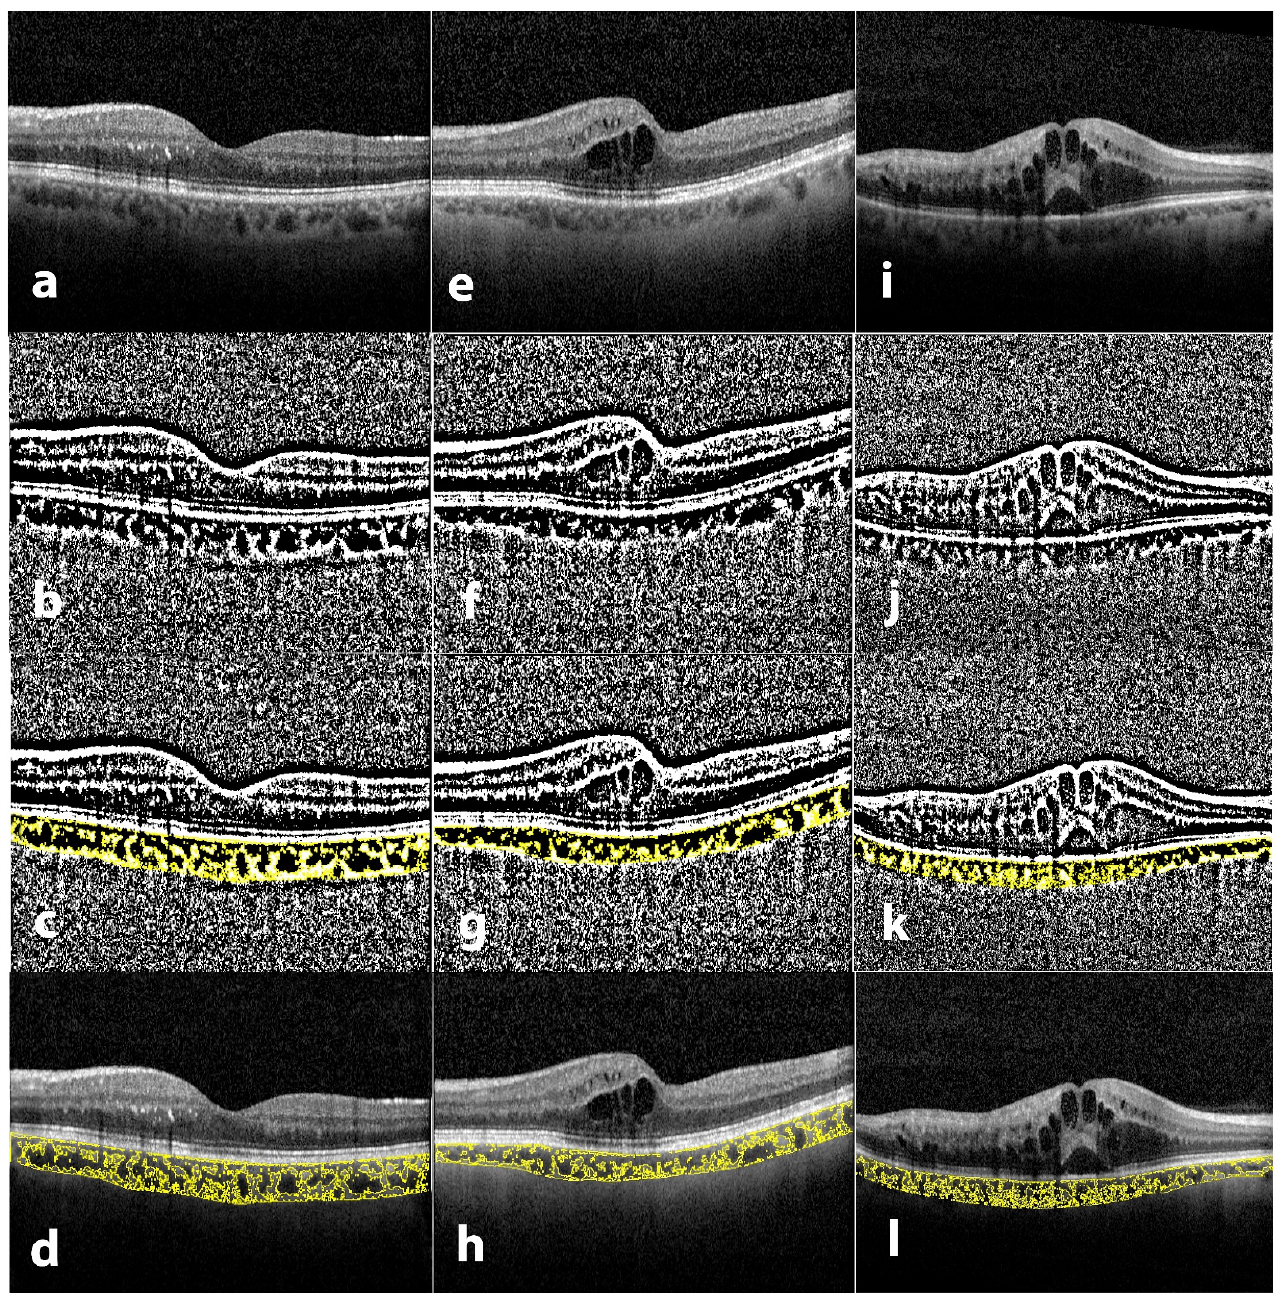
Figure 1. Binarization and identification of the luminal and stromal areas of the choroid. Spectral- domain optical coherence tomography (SD-OCT) acquired using enhanced deep image (EDI) mode. ( a , e , i ) Original subfoveal scan; ( b , f , j ) The image was downgraded to 8-bit and Niblack auto local threshold was applied; ( c , g , k ) Color threshold was used to select luminal area; ( d , h , l ) Overlay of region of interest on the original image. Depending on the pattern of macular edema, eyes were classified into 3 categories: no macular edema ( a ), cystoid macular edema ( e ), cystoid macular edema with serous retinal detachment ( i ).